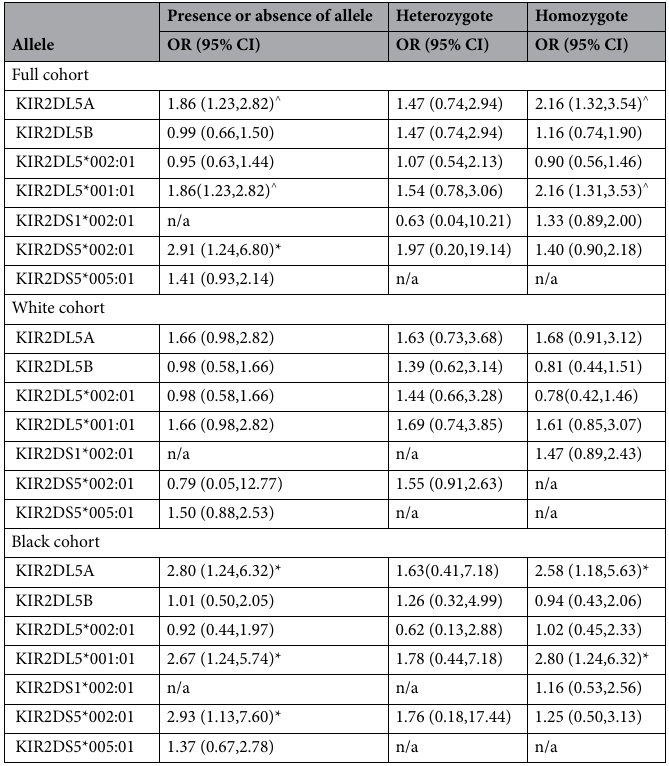
Table 2. Odds ratios and 95% CI for the association of atopic dermatitis by KIR alleles of interest (allelic frequency of > 0.05). Presence or absence of the allele of interest as well as the allele of interest as a heterozygote or homozygous (gene present and homozygote for the allele). For 2DL5 composite was presented for alleles near telomer (A) or centromere (B); A—KIR2DL5*001:01:01, KIR2DL5*001:02, KIR2DL5*001:03, KIR2DL5*001:09:01; B—KIR2DL5*002:01:01 KIR2DL5*002:03, KIR2DL5*003, KIR2DL5*004, KIR2DL5*013:01. n/a—unstable estimate due to insufficient sample size; *p < 0.05, ^ p < 0.005.